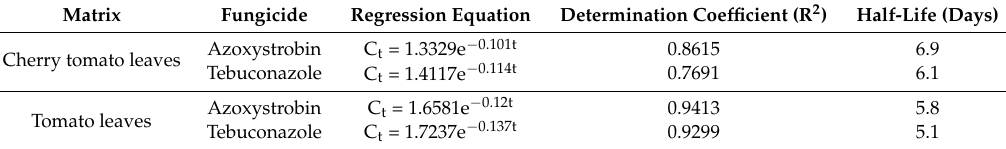
Table 4. Half-life and other parameters for azoxystrobin and tebuconazole dissipated in leaves.